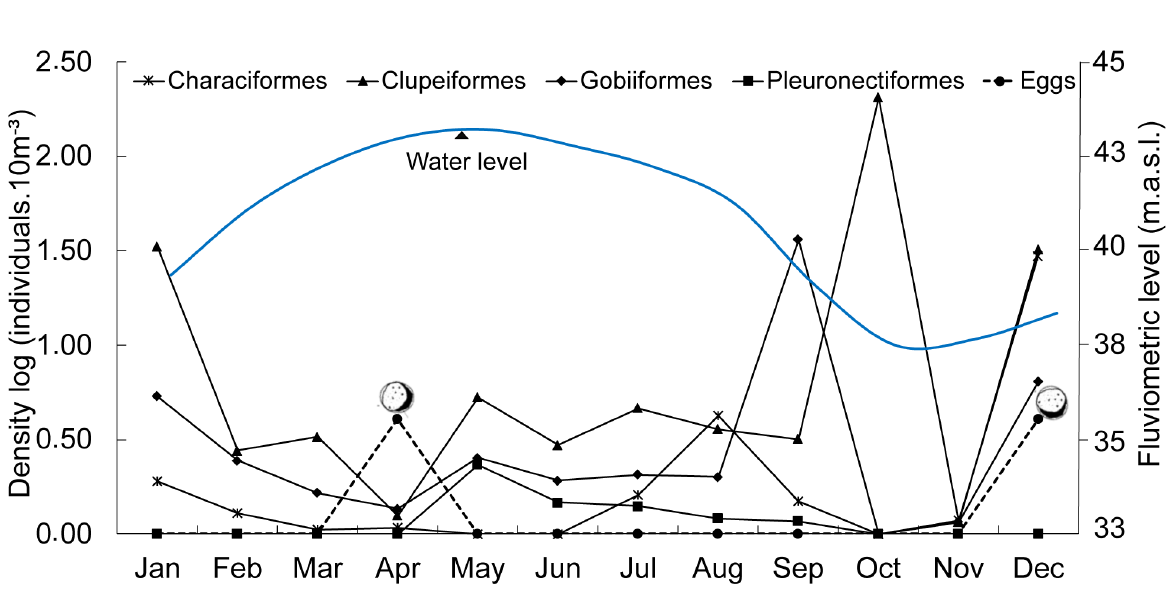
Figure 3. Variation of the density (log transformed) of orders with relative abundance above 2% over the sampling period in Lake Juá and variation of the water level of the Tapajós River, state of Pará, Brazil. m.a.s.l = meters above sea